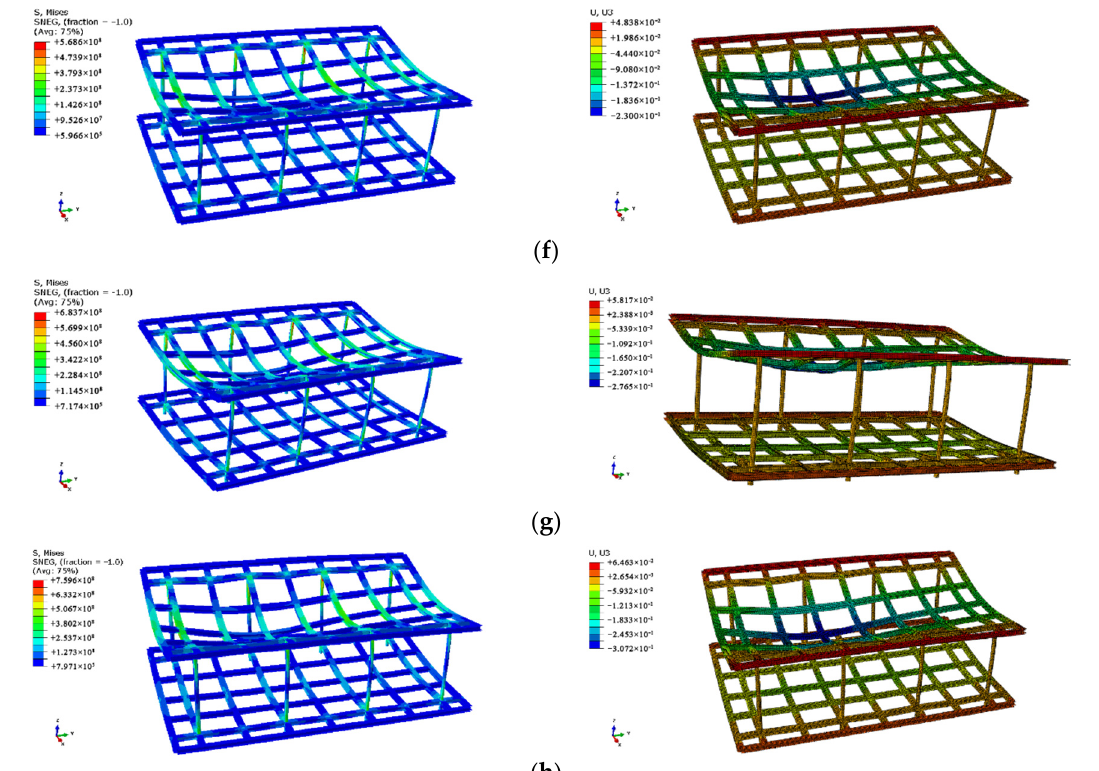
Figure 21. Stress and deformation at different time: ( a ) 1000 s; ( b ) 5000 s; ( c ) 8000 s; ( d ) 10,000 s; ( e ) 12,000 s; ( f ) 15,000 s; ( g ) 18,000 s; ( h ) 20,000 s.